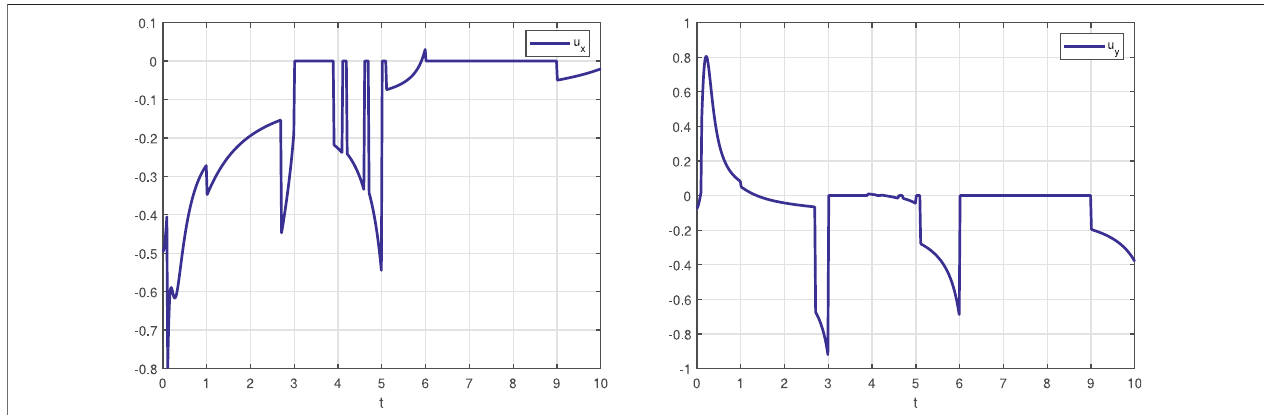
FIGURE 2 | The control input signal ( u x left, u y right) that realized the STL task speci fi cation φ 1 expressed in ( 27 ).